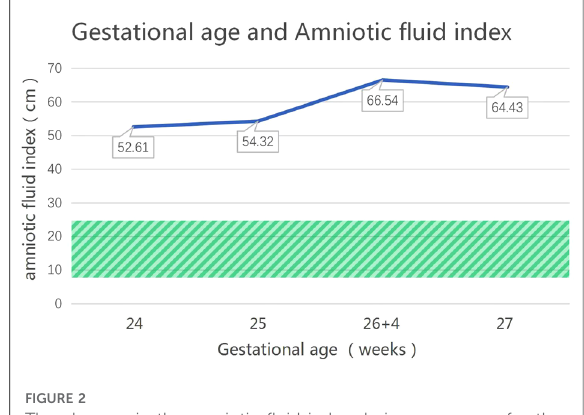
FIGURE 1 Pedigree of the family. The arrow denotes the proband and the hollow symbols represent the unaffected members and add a little to the hollow symbols represent the carrier.